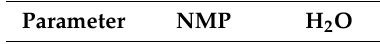
Table 3. Structural data of LFMP determined using the R IETVELD refinement of X-ray diffraction data for water- and NMP-based cathodes. The standard 1 σ -deviations of the refinement for the last digits are given in parentheses.